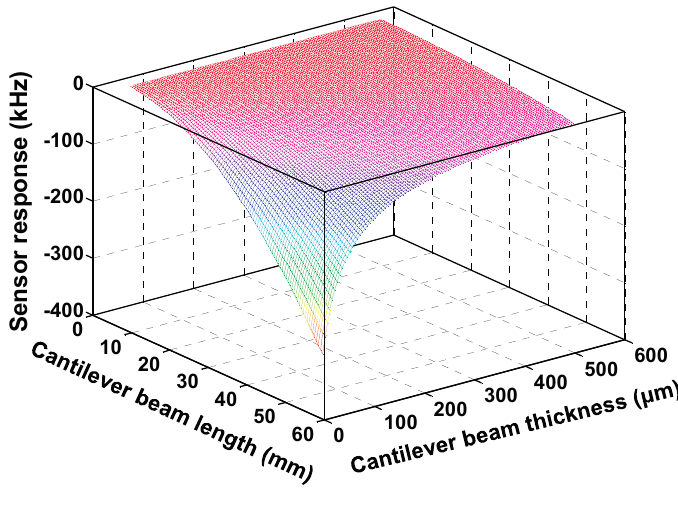
Figure 3. The calculated relationship among the sensor response, length and thickness of the cantilever beam, applied acceleration: 1